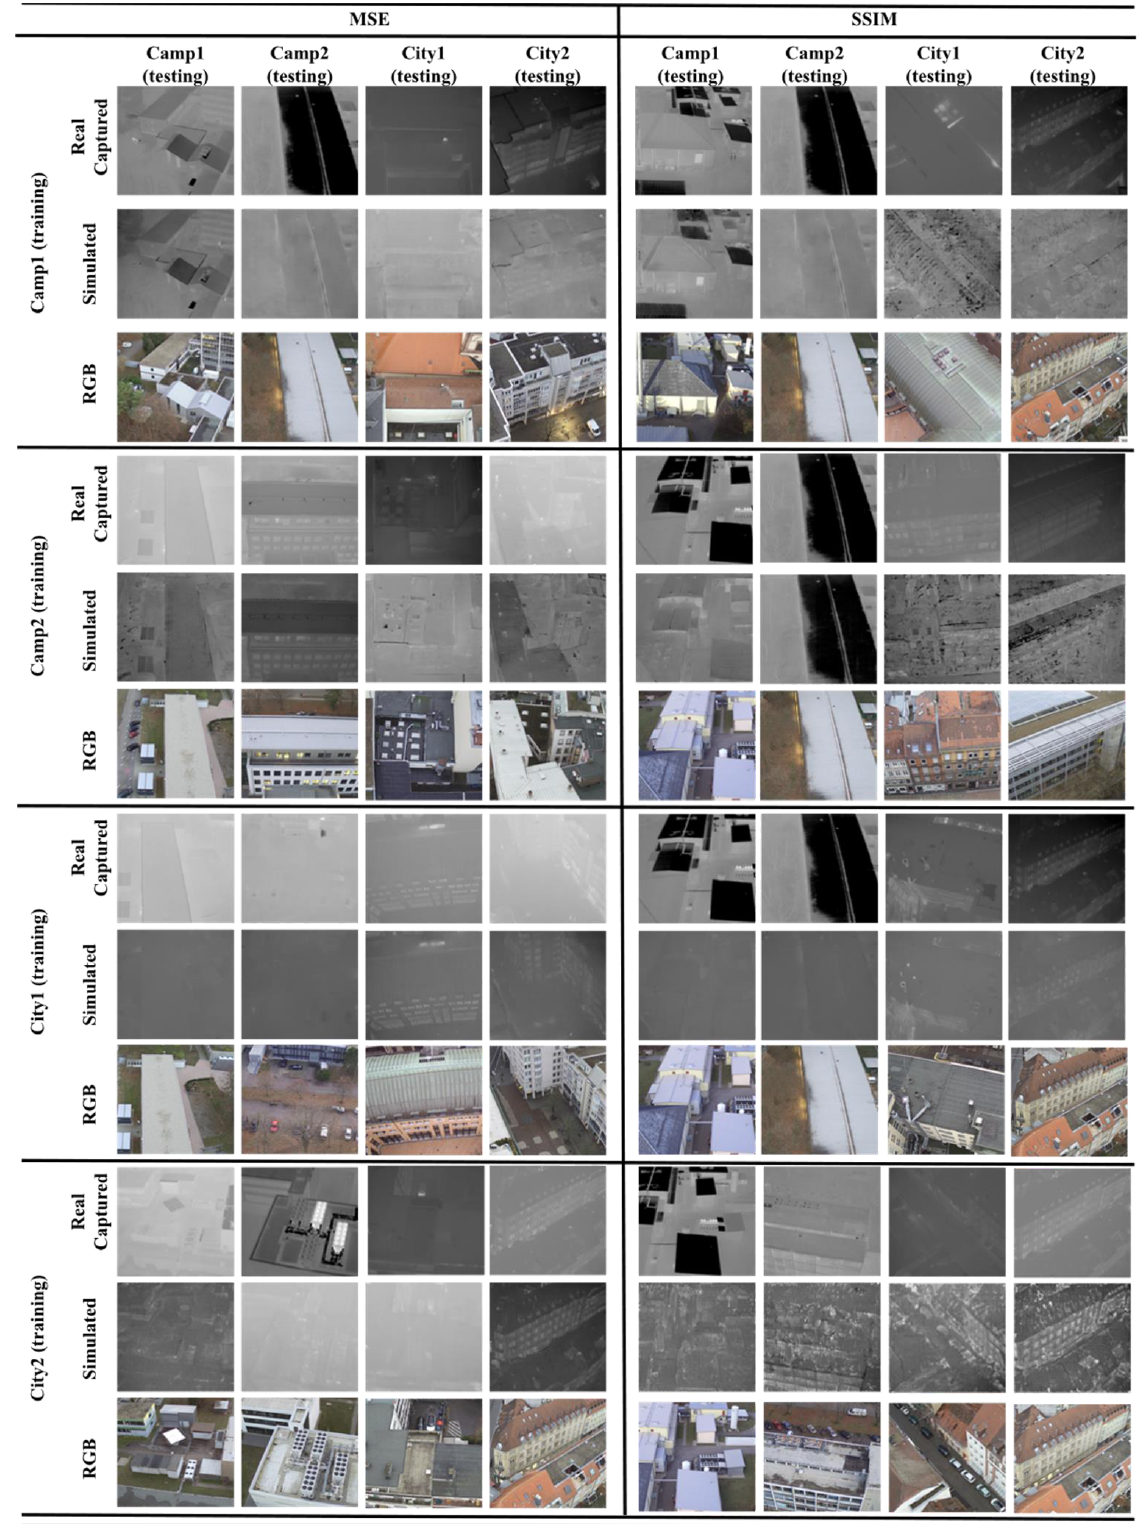
Figure 4. Selected images with highest MSE and lowest SSIM in each evaluation.